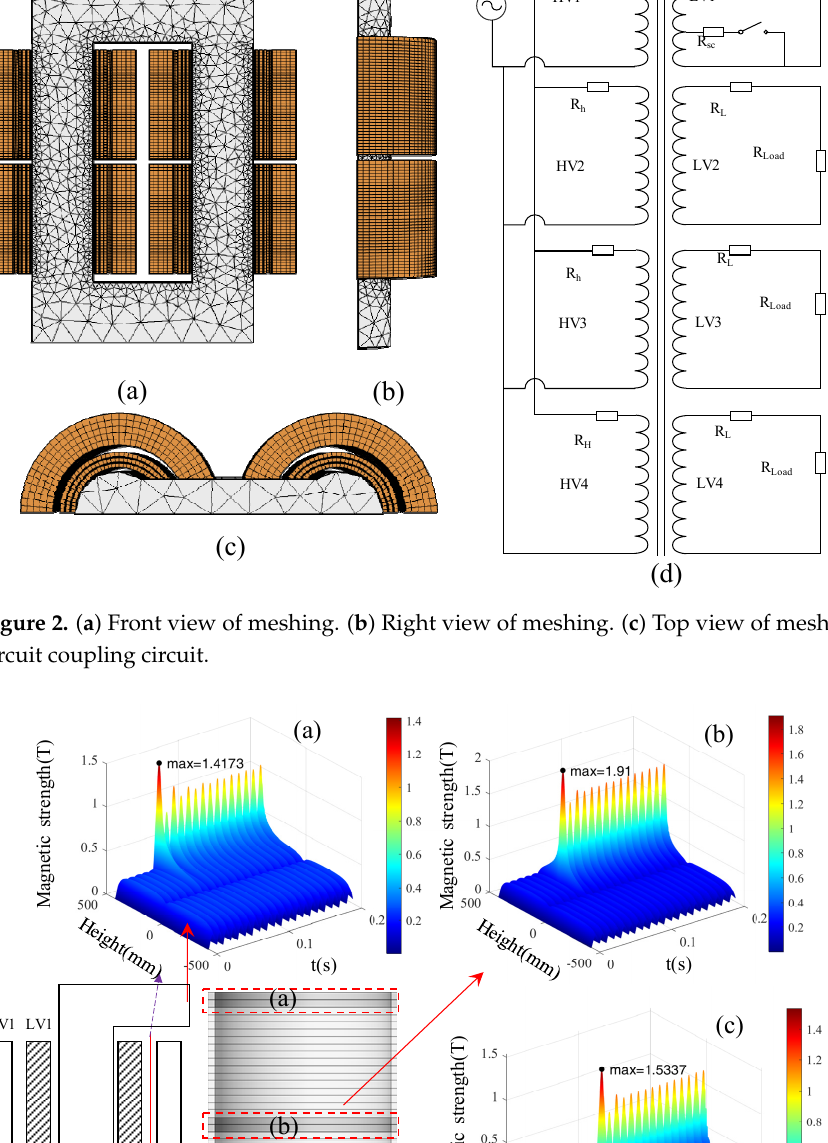
Figure 2. ( a ) Front view of meshing. ( b ) Right view of meshing. ( c ) Top view of meshing. ( d ) Field circuit coupling circuit .